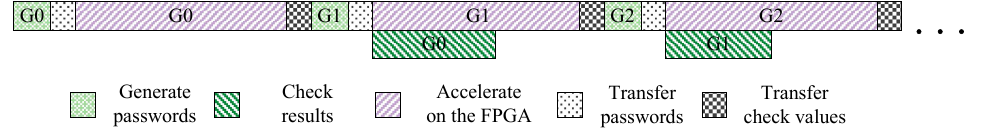
Figure 8: Task arrangement between the CPU and the FPGA. The task of checking results in the group 0 (G0) and the FPGA acceleration in the group 1 (G1) are processed concurrently, which is the same for subsequent groups like the group 1 and group 2